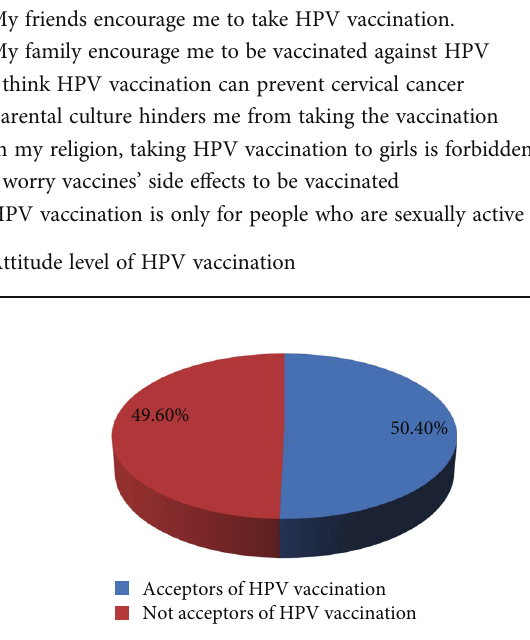
Figure 2: Level of acceptance of HPV vaccination among girl students in Arba Minch town, Southern Ethiopia,